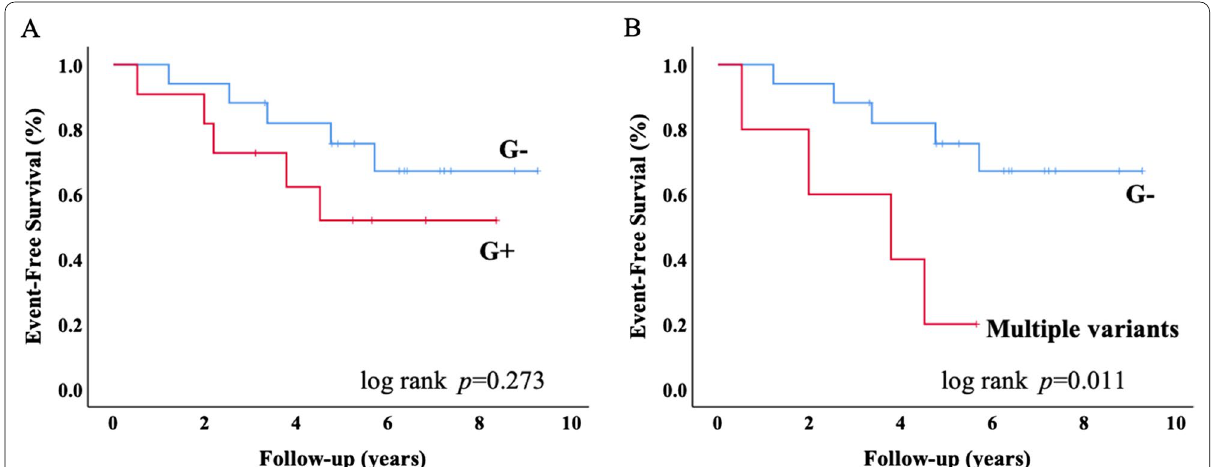
Fig. 5 Kaplan–Meier survival curves for survival free of the primary endpoint according to positive genotype ( a ) and multiple genetic mutations ( b ). G genotype positive, G genotype + −